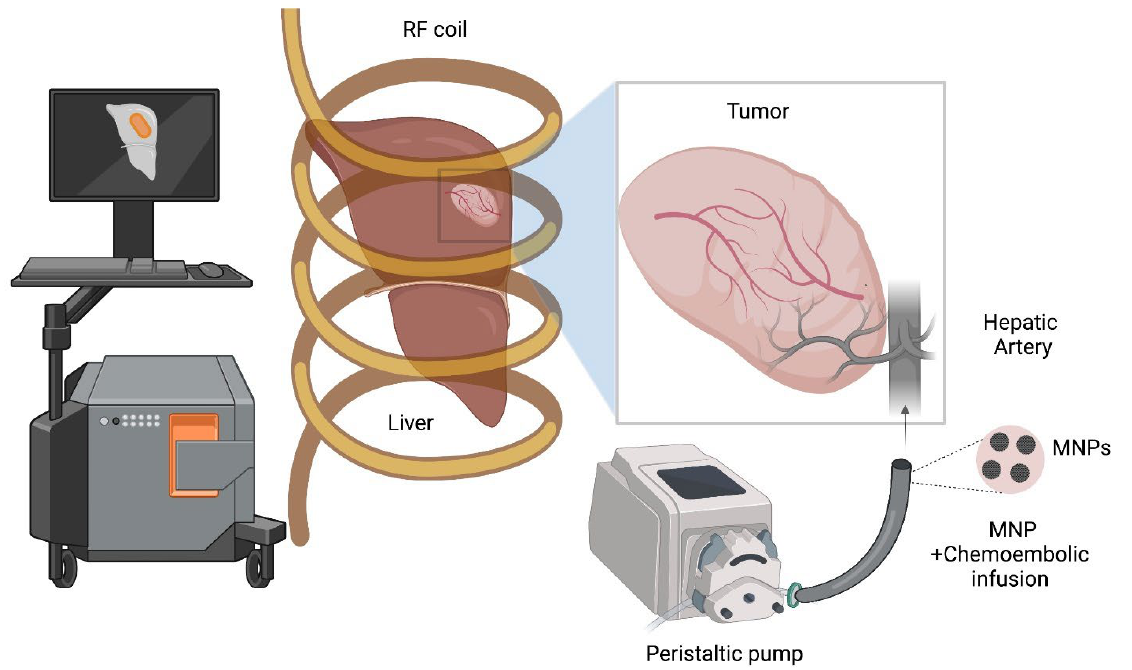
Figure 1. A schematic depicting the image-guided magnetic hyperthermia therapy (MHT) combined with TACE in hepatocellular carcinoma (HCC). Imaging modalities with high contrast and spatial resolution (e.g., MRI for contrast resolution, CT for spatial resolution, and MPI for both) allow for the characterization of MNP distribution relative to the liver lobes, tumor, and vasculature, following intra-arterial perfusion of MNPs with chemo-embolics. This enables patient-specific treatment planning and implementation of the MHT treatment (e.g., temperature probe placement, power and amplitude modulation schemes).